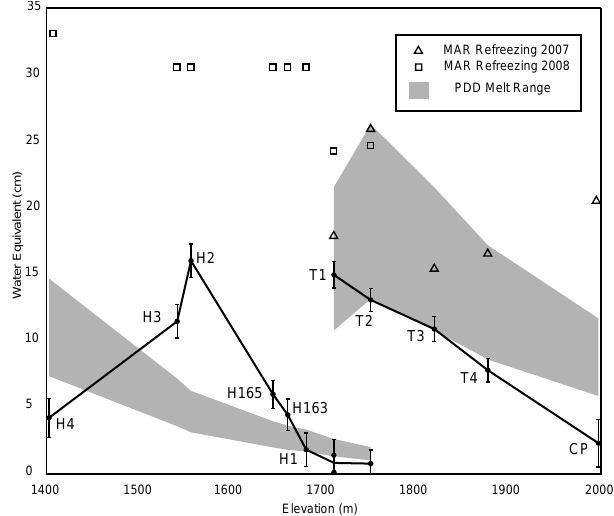
Figure 3. Refreezing quantities at each site with error bars equal to ± 2 standard deviations. A line connects sites with data from the same melt season (either 2007 or 2008). The grey region is an es- timated range of surface melt at each elevation, calculated using a positive degree-day model. Triangles and squares are refreezing quantities output by the regional climate model MAR. MAR values are associated with the model grid cell encompassing the site and correspond to the time periods used to calculate refreezing values shown in Table 1.